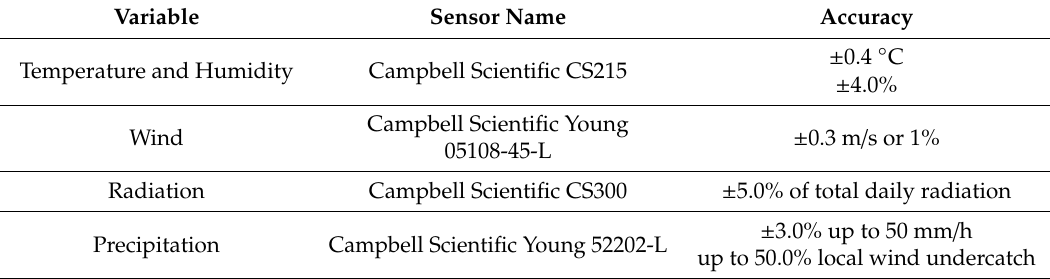
Table 2. Sensor types and accuracies of AWSs Centinella (CE) and Nunatak Grey (NG).